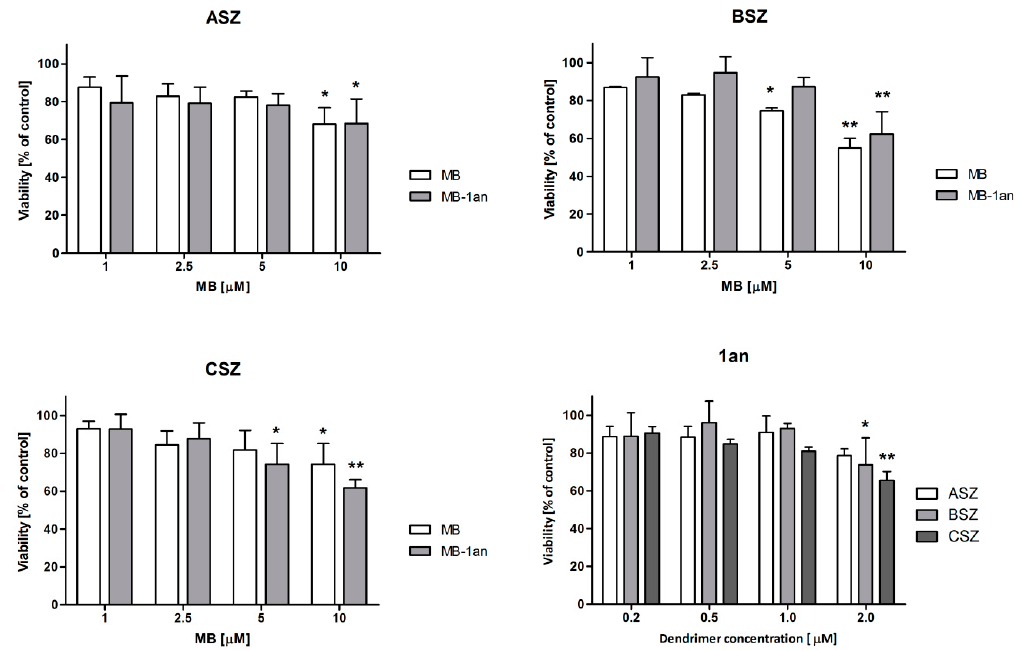
Figure 3. Viability of ASZ, BSZ, and CSZ cell lines after the treatment with MB, MB-1an and 1an without irradiation (dark toxicity). The concentrations of MB varied from 1 to 10 µM, whereas the dendrimer concentration used ranged from 0.2 to 2.0 µM. * p < 0.05, ** p < 0.01.